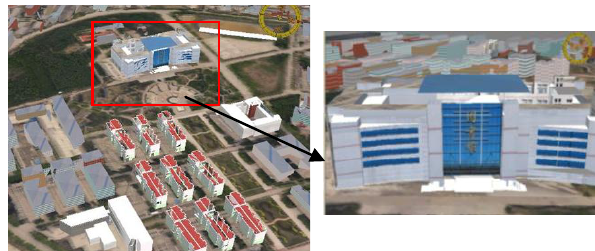
Figure 12. 3D effect graph of the library